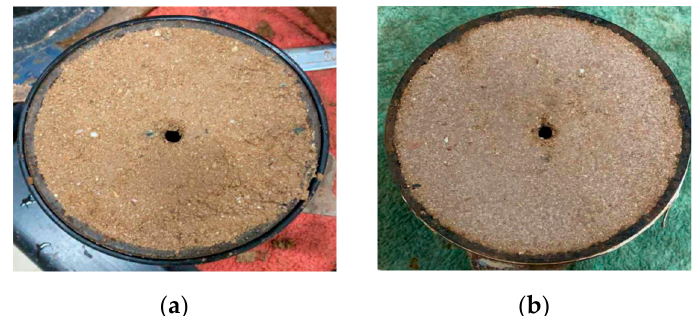
Figure 8. Final hole diameter ( φ f ) for some of the Soil #1 tested samples: ( a ) 1% lime at 1 day curing and ( b ) 5% lime at 2 days curing.